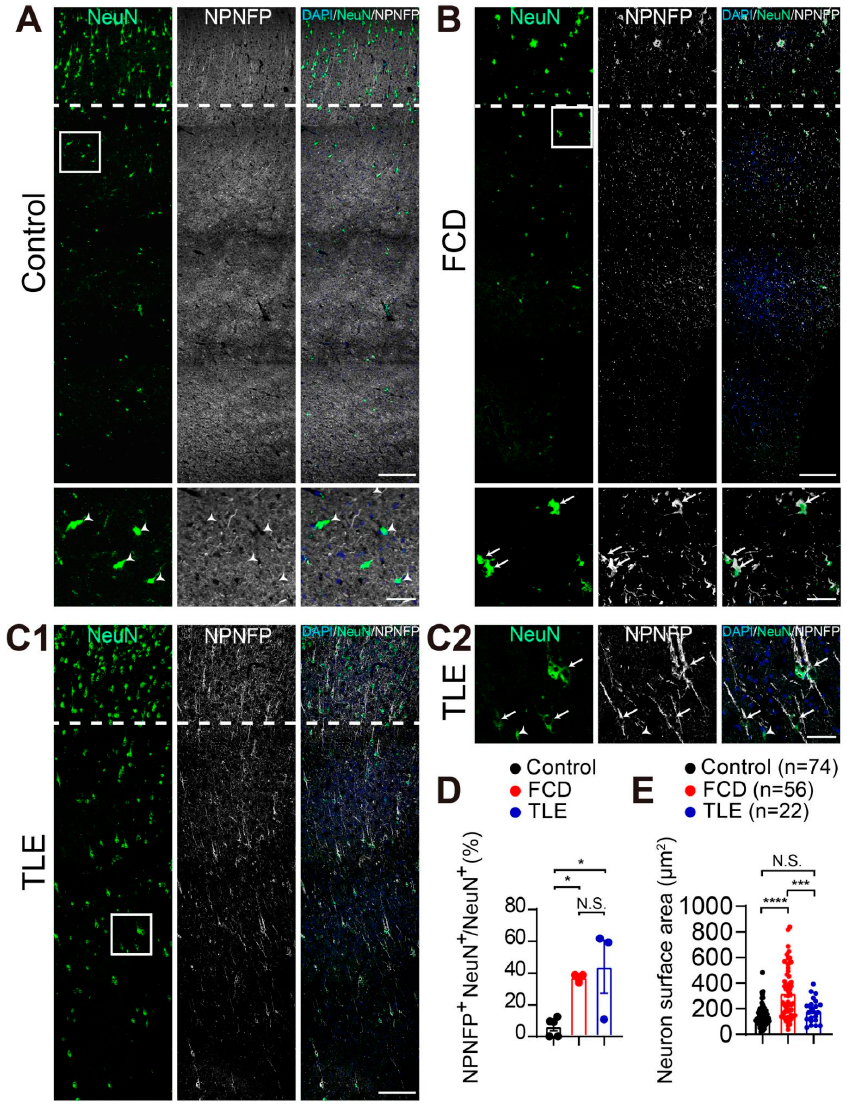
Figure 2. Increased NPNFP expression in interstitial neurons in the white ma tt er of drug-resistant epilepsy patients. ( A ) Tile scan images and zoom-in images (bo tt om) showing the expression of NPNFP in interstitial neurons in the white ma tt er of brain tissue sections from 3 independent sam- ples of control, FCD ( B ), and TLE ( C1 , tile scan image; C2 , zoom-in image). Arrows indicate the co- expression of NPNFP with NeuN. Arrowheads indicate that no NPNFP expression was detected in the interstitial neurons. Scale bar, 200 µm in the tile scan image (up) and 50 µm in zoom-in image (bo tt om). A dashed line indicates the border between gray ma tt er and white ma tt er. NPNFP: non-